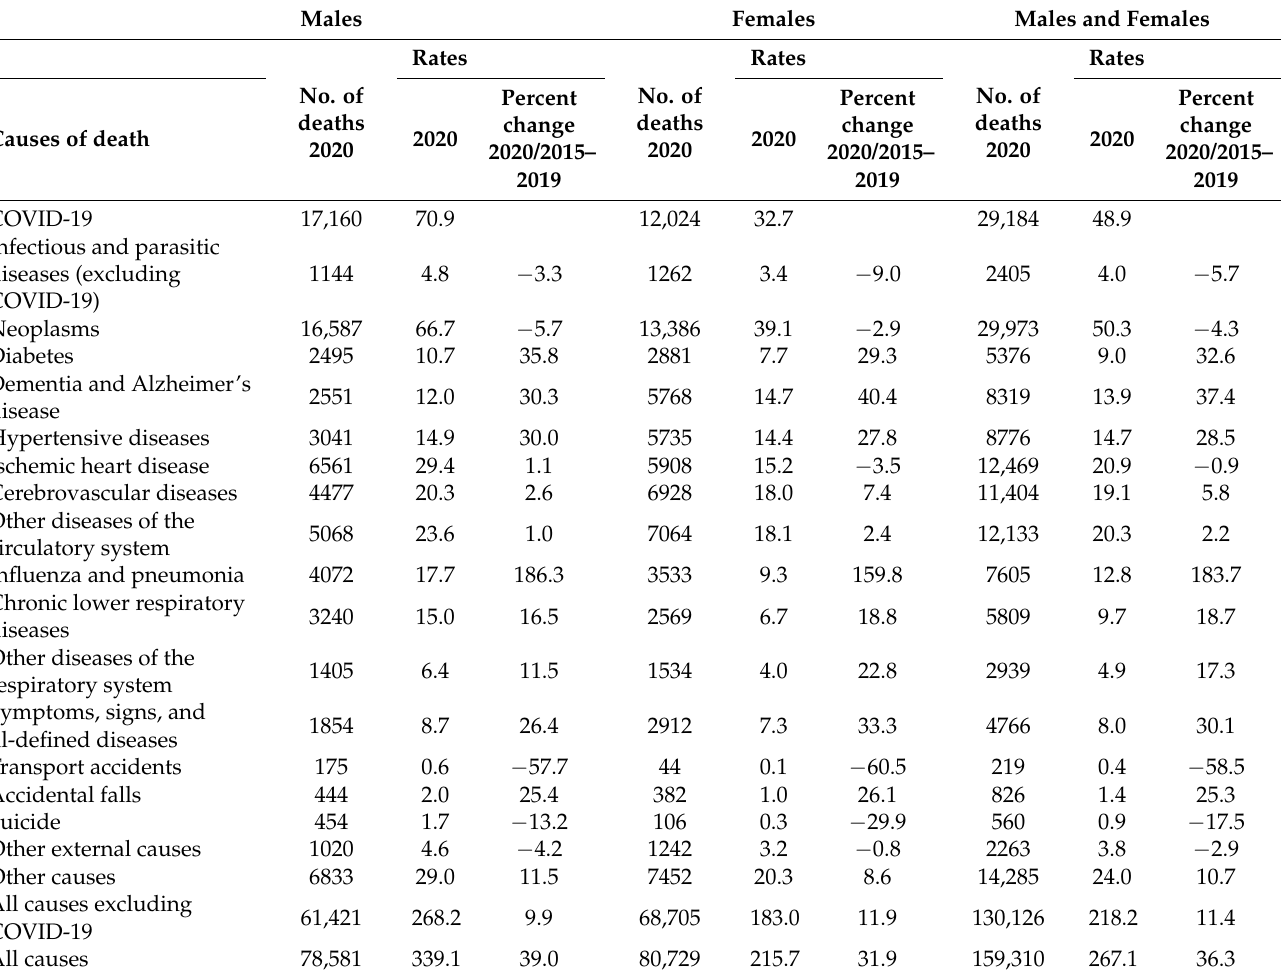
Table 1. Mortality by cause in Italy from March 2020 to April 2020 for all ages: estimated number of deaths, age-standardized mortality rates (per 100,000 residents), and percent change in rates compared with respect those in